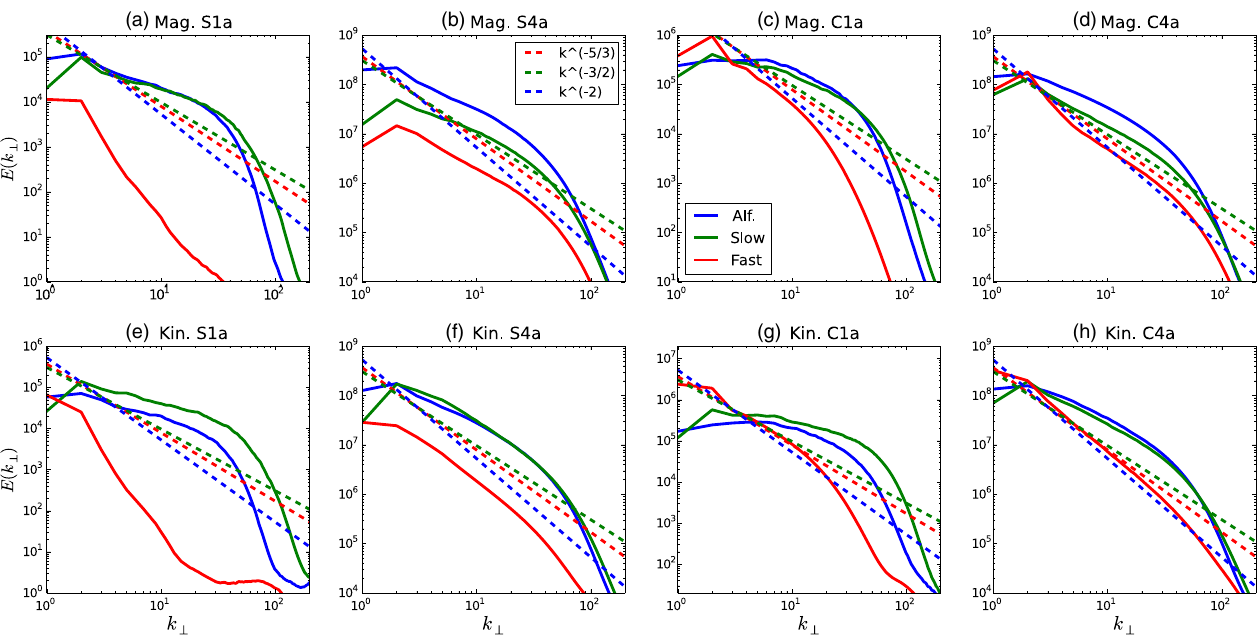
FIG. 3. Energy spectra of the different MHD modes showing a comparison between S1a, S4a, C1a, and C4a simulations. The top row is the spectrum of magnetic fields, and the bottom row shows the velocity field spectrum. Three reference slopes are also plotted giving k − 3 = 2 k − 5 = 3 k − 2 ⊥ slopes. The legend applies to all the ⊥ , ⊥ , and